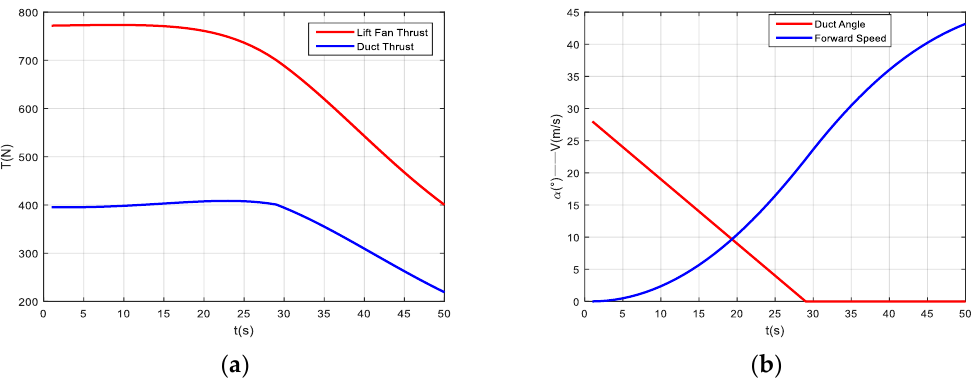
Figure 12. ( a ) Slow transition of lift fan and lift duct thrust state; ( b ) Slow transition of forward speed and lift duct deflection.